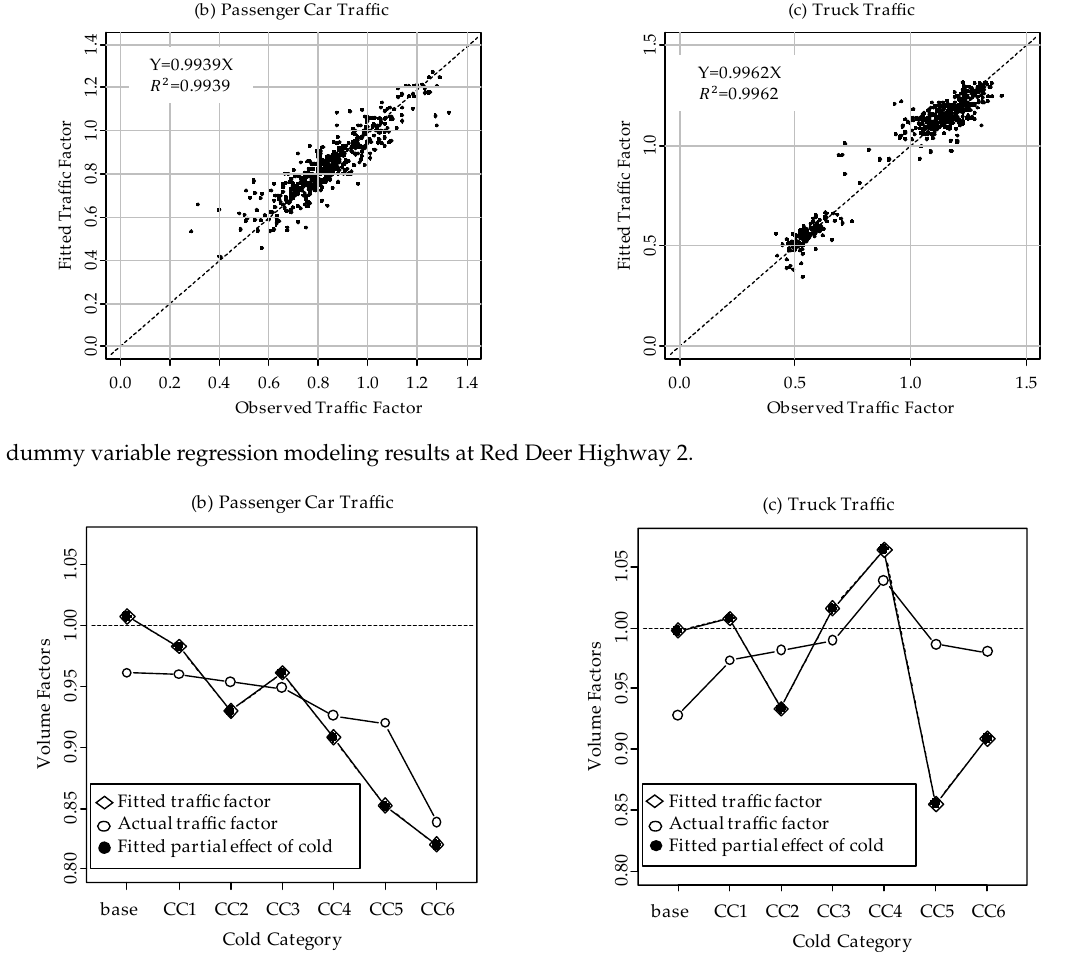
Figure 9. The marginal effect of cold categories on traffic volume factor at Leduc 2A.